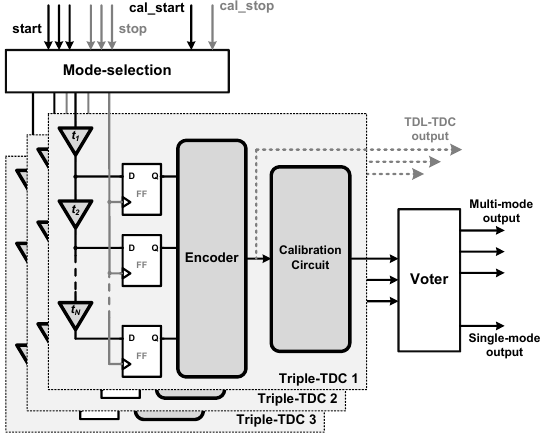
Figure 3. Architecture of the proposed